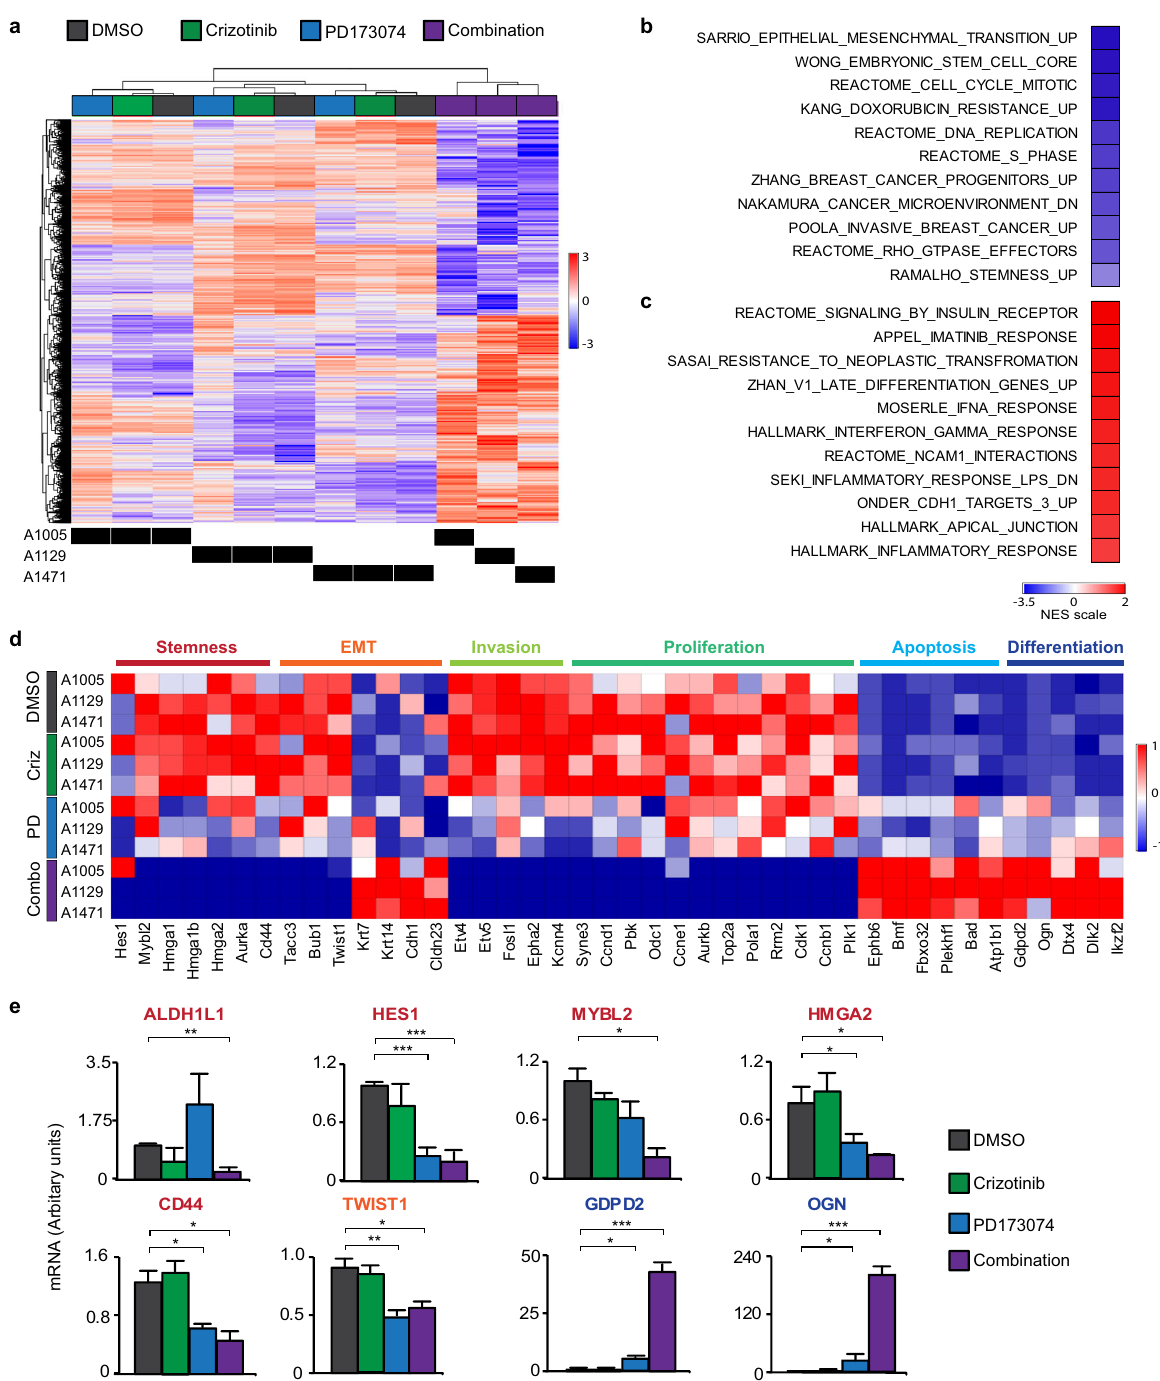
Fig. 4 Co-inhibition of Met and FGFR1 signalling in TICs abrogates EMT, stemness and proliferation, and induces cell differentiation. a Tumourspheres generated from three independent MMTV- Met mt ; Trp53 fl / + ; Cre spindloid tumour cell lines were treated for 24 h with DMSO, Crizotinib, PD173074, or a combination of both agents. RNA was extracted from treated tumourspheres and subjected to RNA-Sequencing. Unsupervised hierarchical clustering of all genes that were differentially expressed in each pairwise comparisons tested with adjusted P value ≤ 0.05 (BH method). b , c Heatmap showing changes in the normalised enrichment score (NES) for the most enriched pathways in tumourspheres treated for 24 h with DMSO, Crizotinib, PD173074 and a combination of both agents (1 μ M for both inhibitors) (FDR P ≤ 0.05). The top-up and downregulated gene signatures of Hallmark, genetic and chemical perturbations and Reactome pathways. d Heatmap representation of the relative expression of known phenotypic markers for each indicated cellular process. e Quantitative RT-PCR for the indicated genes. * P ≤ 0.05; ** P ≤ 0.01; *** P ≤ 0.001. Error bars indicate